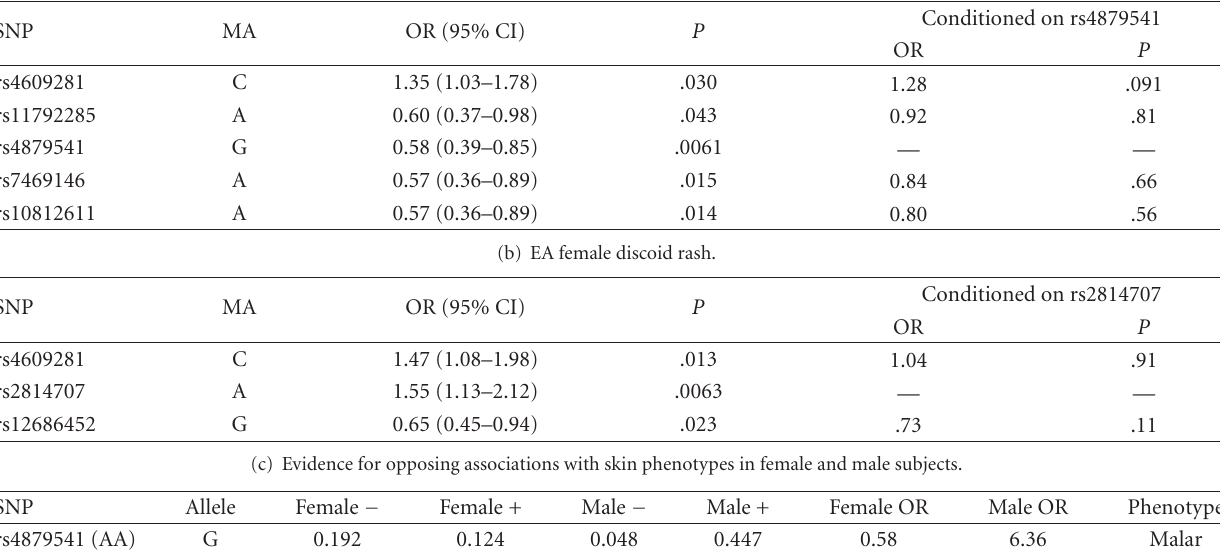
Table 5: Markers suggestive of association with skin-related clinical criteria. “Conditioned on ... ” = results from conditional logistic regression performed conditioning on the indicated SNP, MA: minor allele, “Case” and “Cont”: allele frequency of the minor allele in cases and controls respectively, OR: odds ratio, 95% CI = 95% confidence interval of the odds ratio, P : P value, AA: African-American ancestry, EA: European ancestry, Female − : female subjects lacking the indicated skin phenotype, Female +: female subjects with the indicated skin phenotype, Male − : males lacking the indicated skin phenotype, Male +: males with the indicated skin phenotype, Female ORs: odds ratio comparing female patients with and without the indicated skin phenotype, and Male OR: odds ratio comparing male patients with and without the indicated skin